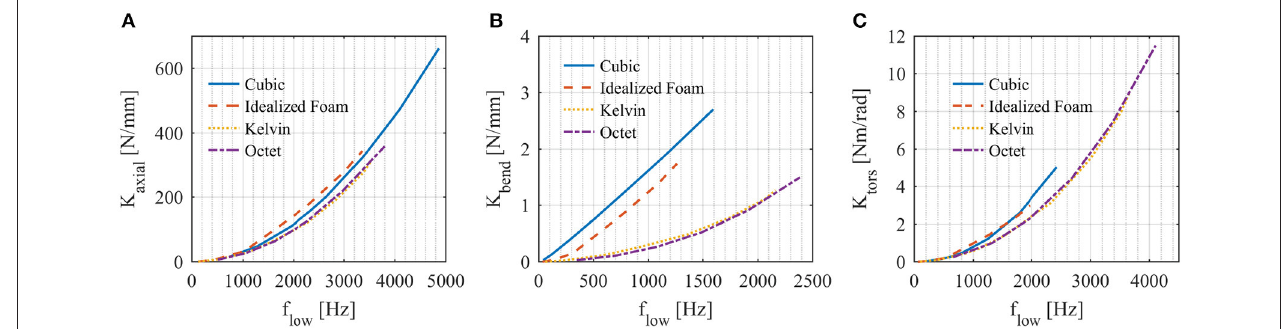
TABLE 5 | Material properties used for finite element simulations. Material Density (kg/m 3 ) Young’s modulus